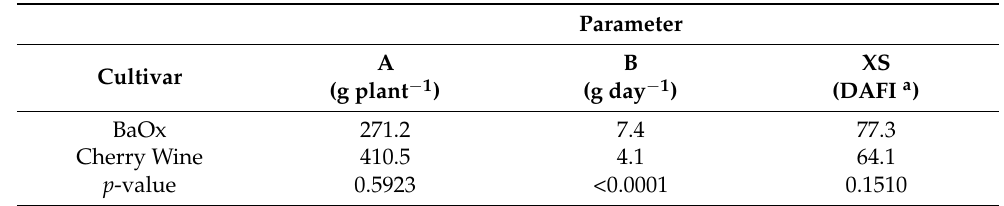
Table 2. Parameter estimates of the linear plateau nonlinear regression for individual plant biomass production over time for the floral hemp cultivars BaOx and Cherry Wine.